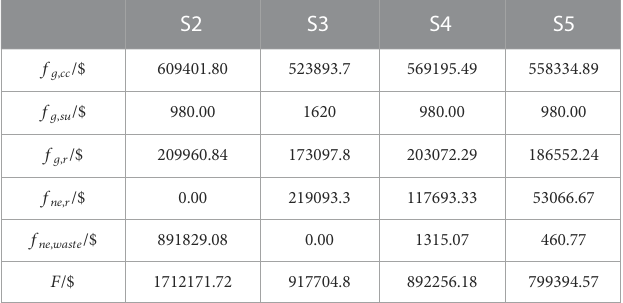
TABLE 4 Costs of the four scheduling